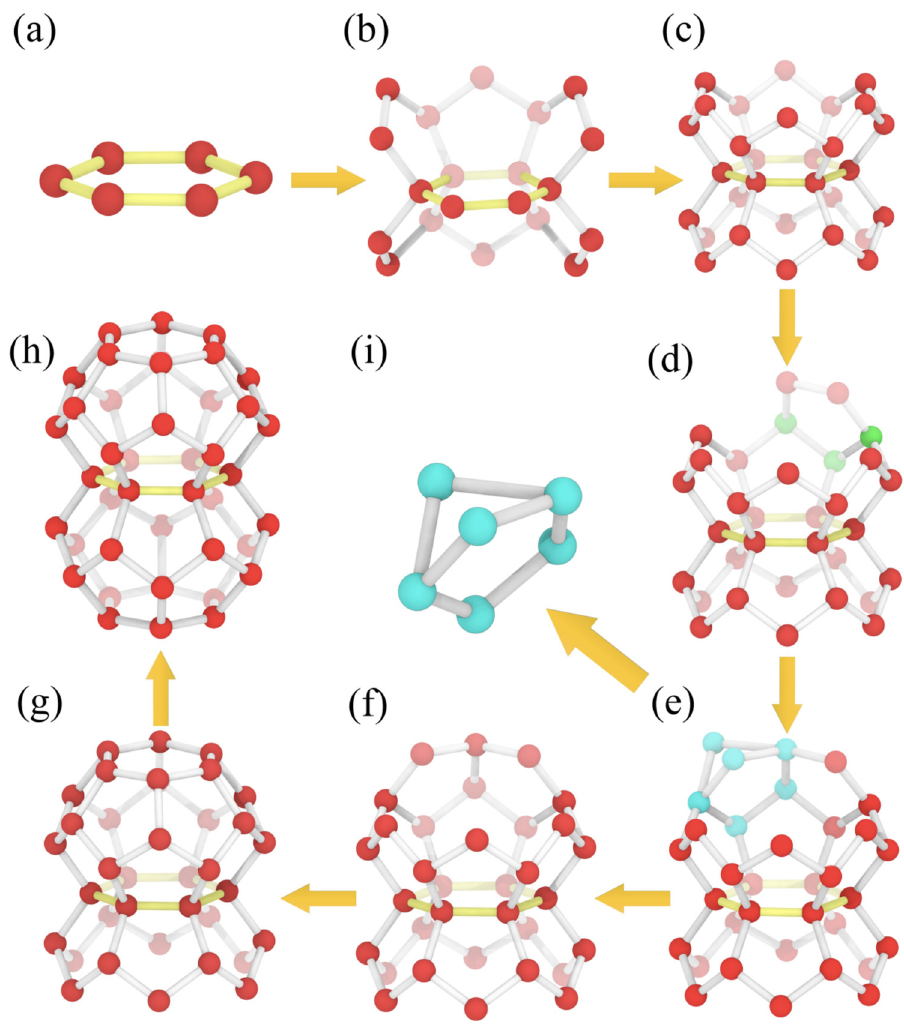
Figure 2: Scheme of HTR algorithm. Choosing a ring ( a ) as the bottom ring, we can fi nd all the rings that share a hydrogen bond with this ring. Through the process ( b ) , the algorithm can fi nd all the rings that share a hydrogen bond with this ring and obtain the two half - cage structures that share the same ring in ( c ) . Select one of the half cages for the topology of rings, and the three green water molecules at the edge of the upper half of the cage in ( d ) can generally be located in the unique ring from the identi fi ed ring library. Repeat the ring topology process, and if the cage cannot be closed, go back to step ( e ) to use another ring for topology. If the cage is closed, as shown in ( g ) , repeat the aforementioned topological process for the lower half of the cage and fi nally get a double - cage structure sharing a ring in ( h ) . If the two rings in ( i ) share more than three water molecules, the HTR algorithm will fi rst select one of the rings to obtain the structure ( f ) and then proceed to the next